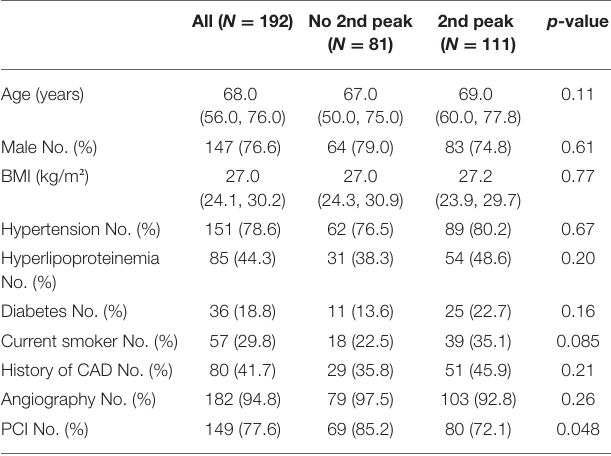
TABLE 1 | Baseline characteristics of patients with and without a second hs-cTnT peak.